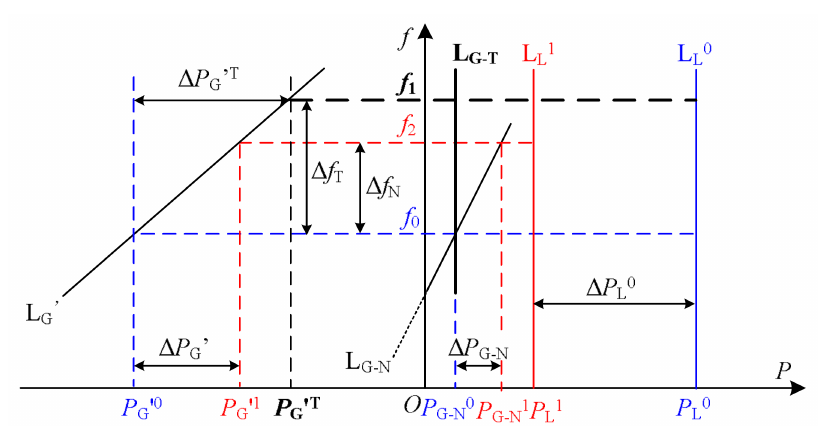
Figure 24. S-L analysis of multi-power system including input/output bidirectional devices in the motor